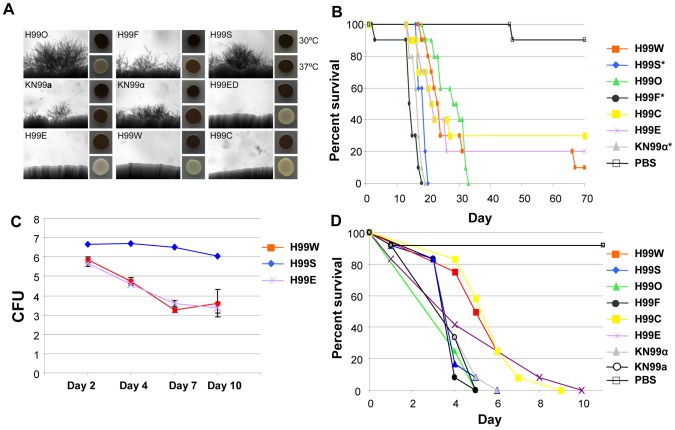
H99 passaged strains exhibit phenotypic variability.
A. Mating assays on V8 agar were incubated at room temperature for seven days in the dark. Each strain was mated with KN99a (except KN99a, which was mated with KN99α). Melanization assays were conducted on l–DOPA agar incubated at 30°C or 37°C for two days. B. H99 variants differ in virulence in the murine model of infection. A group of 10 animals was each infected with an inoculum of 5.0×105 cells via intranasal instillation for each strain. The results illustrate virulence variations between these well-defined H99 lineage isolates. A PBS control in which no cells were inoculated was also included. We compared the survival data for the seven strains using the Kaplan-Meier method. The significance of the pairwise comparisons to H99O was determined by the Mantel-Cox log rank test. The average time of survival was significantly shorter for the H99S, H99F, and KN99α strains compared to H99O. The survival times of the other strains compared to those of H99O were not significantly different. C. H99 variants differ in virulence in the rabbit CNS model of infection. For each of the variants (H99S, H99W, and H99E), three rabbits were infected directly into the CNS. All rabbits were immunosuppressed with steroid treatment. Spinal taps were taken on days 2, 4, 7, and 10 and measured for CFU (log scale). All animals were euthanized at the conclusion of the experiment. D. H99 variants differ in virulence in a heterologous host model of infection. For each strain, a group of 12 Galleria mellonella larvae was infected with an inoculum of 1.0×105 cells. Survival was monitored and plotted daily for 10 days. Isolates were significantly virulent (p<0.005) in comparison with the mock control (sterile PBS) infection, and isolates H99C and H99E were significantly less virulent than the H99O reference strain (p<0.05).